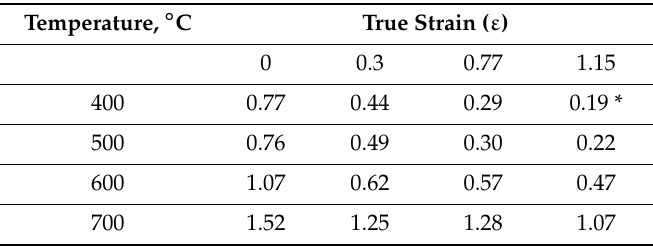
Table 3. Average transverse high-angle boundaries (HAB) spacing ( µ m).